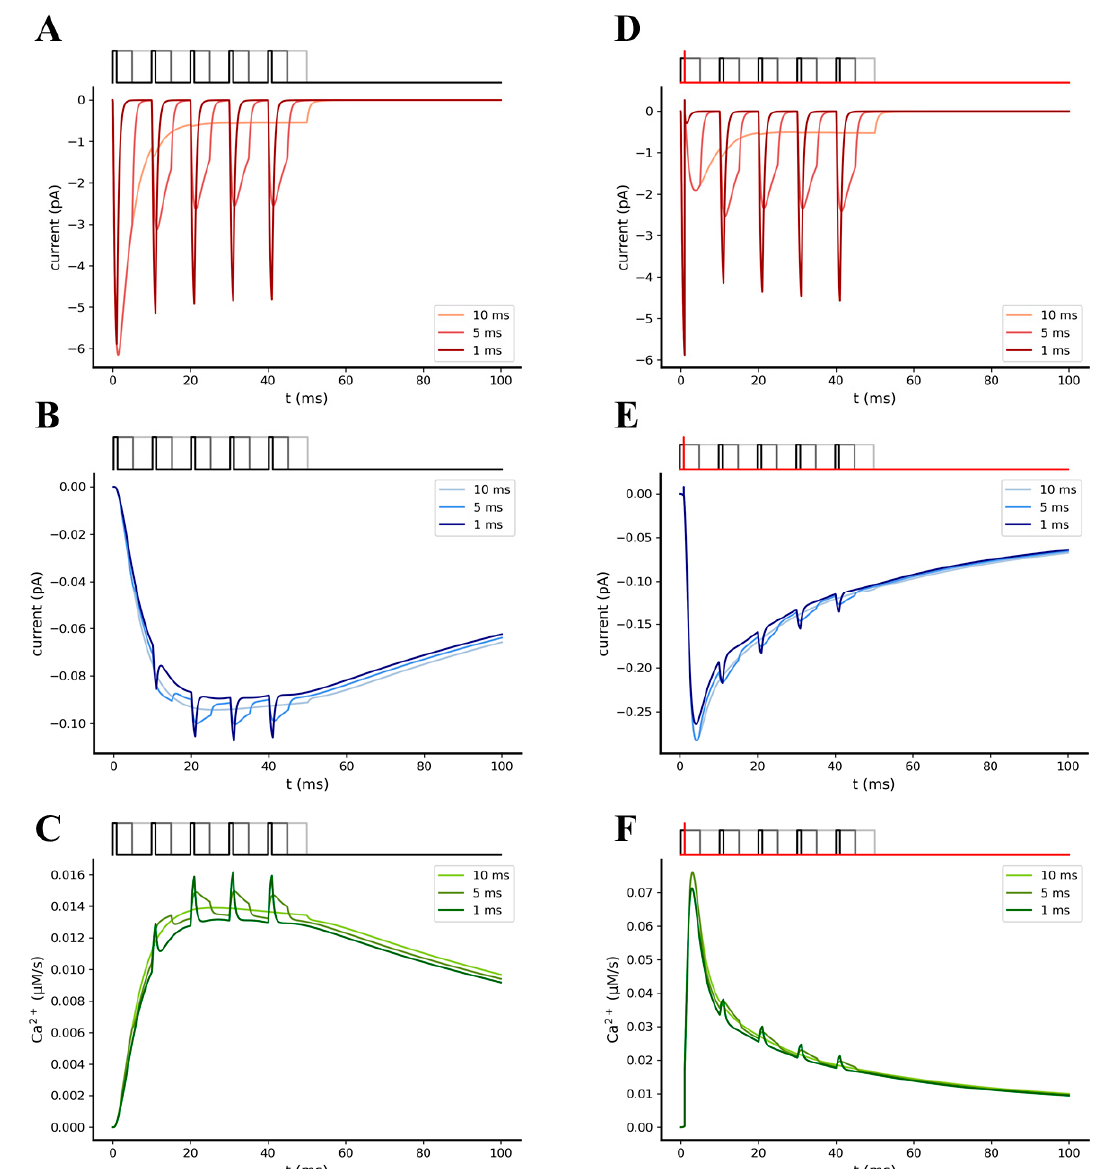
Figure 7. Simulation of synaptic transmission elicited by a single pre-synaptic burst of 5 glutamate pulses, in the absence of ( A – C ) or in the presence of ( D – F ) a single post-synaptic back-propagating action potential (bAP). ( A , D ) Time course of the individual AMPA-mediated EPSC. ( B , E ) Time course of the individual NMDA-mediated EPSC. ( C , F ) Time course of the Ca 2+ molar flowrate that permeate NMDA receptors during the simulations. Pre-synaptic bursts were composed of 5 glutamate pulses of 1 mM amplitude and 1 ms (black pulses), 5 ms (dark grey pulses), and 10 ms (light grey pulses) width; in each plot, the responses elicited by 1 to 10 ms widths are represented by different colors, respectively, from the darkest to the brightest. Post-synaptic activity (red trace) was programmed as a single dendritic back-propagation event that occurs 1 ms after the first pulse of the pre-synaptic burst began. Both simulations were performed in the presence of 20 AMPA, 15 NMDA, and 1 mM of extracellular Mg 2+ .